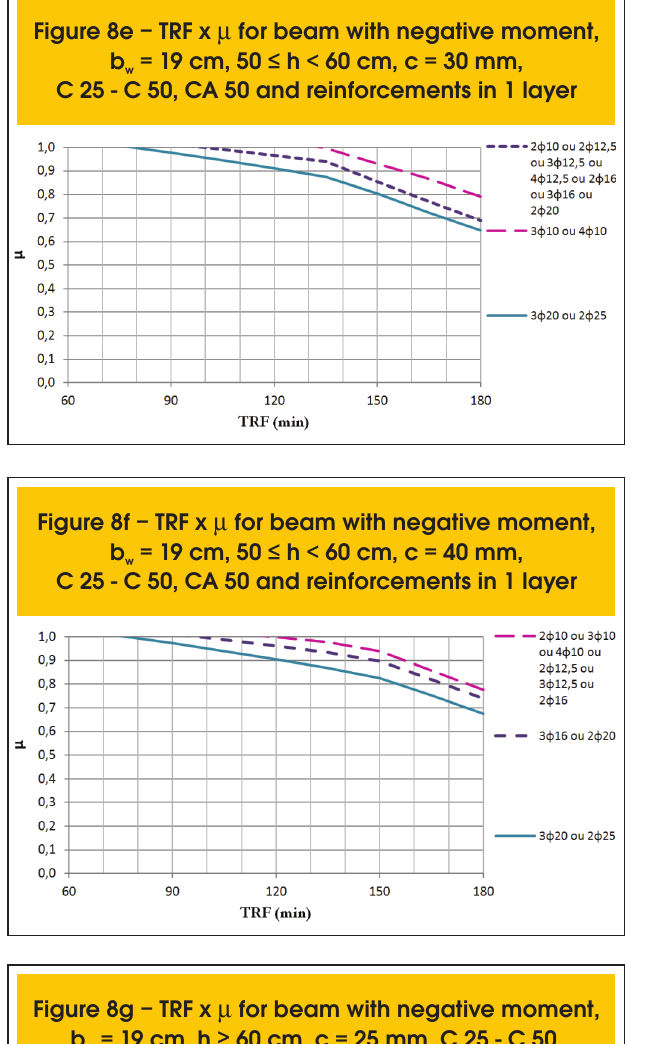
Figure 8j – TRF x m for beam with negative moment, b = 25 cm, 40 ≤ h < 50 cm, c = 25 mm, w C 25 - C 50, CA 50 and reinforcements in 1